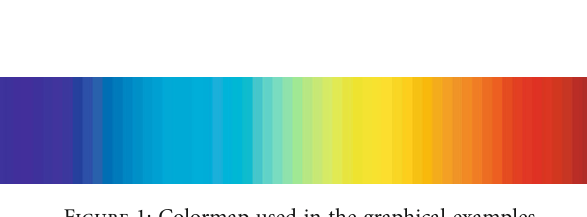
Figure 1: Colormap used in the graphical